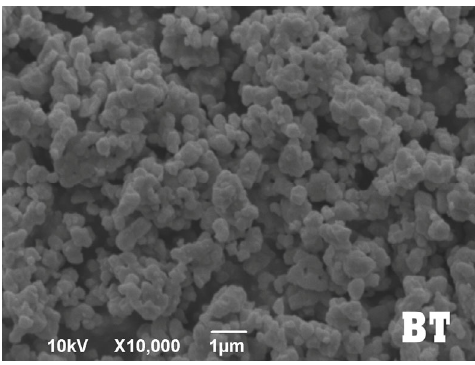
Fig. 3 SEM image of pure BaTiO 3